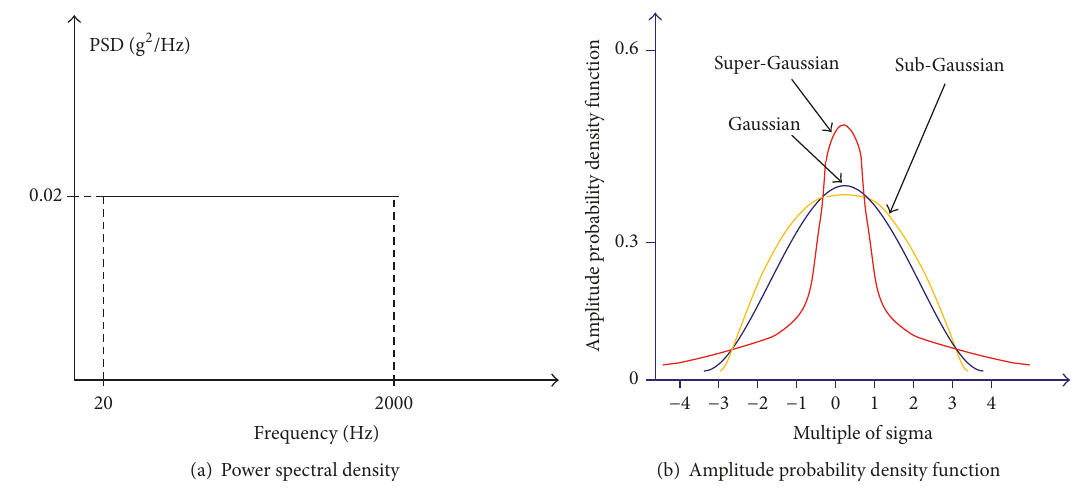
Figure 1: The amplitude probability density function with the same PSD.